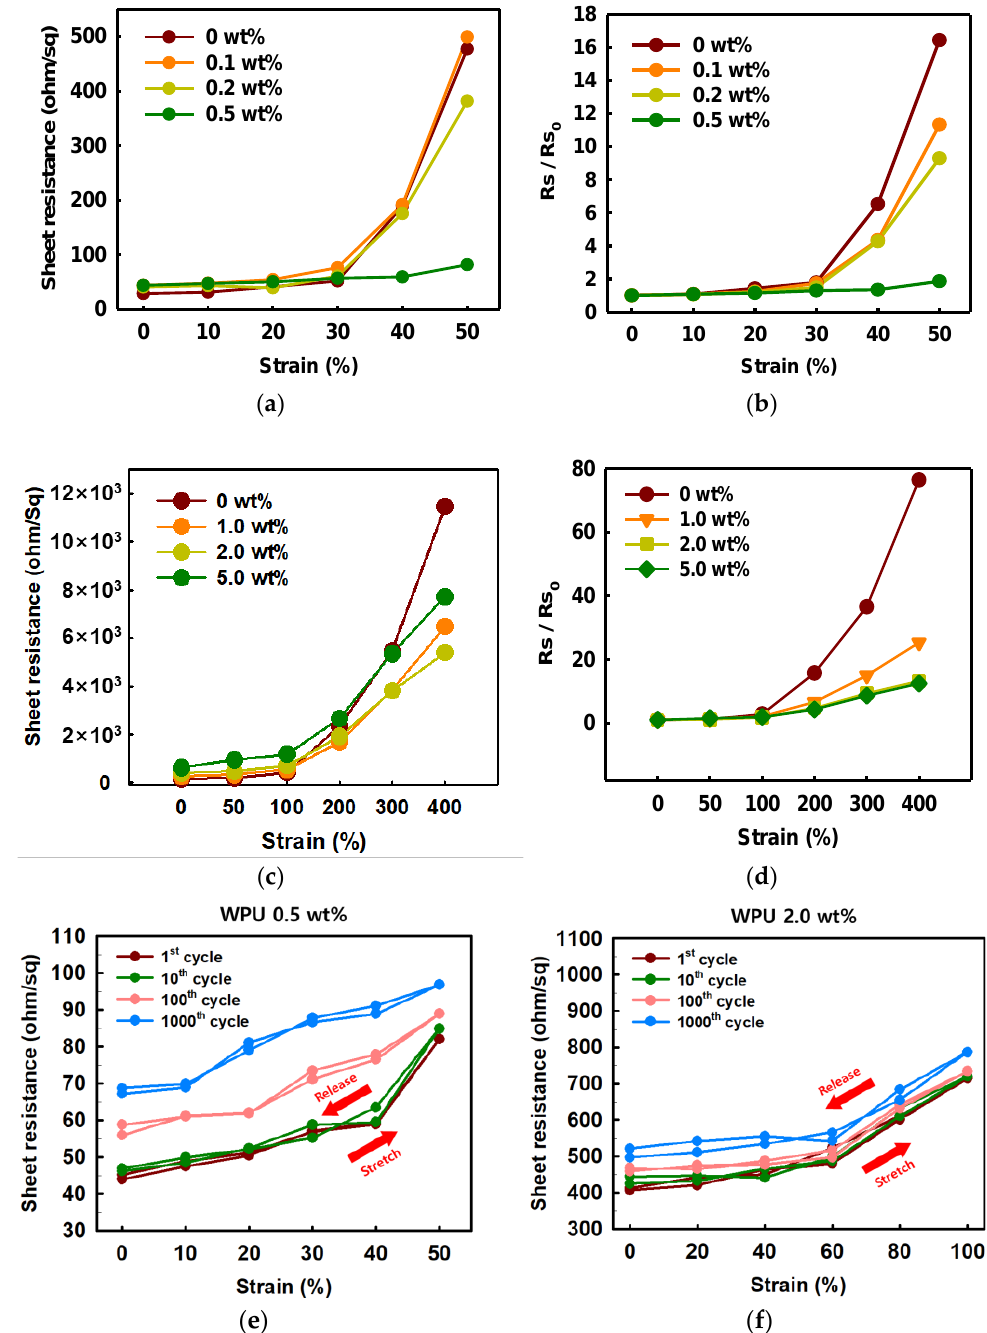
Figure 7. ( a ) Sheet resistance and ( b ) normalized sheet resistance of PEDOT:PSS films with various concentrations of WPU when TPU substrates were strained from 0% to 50%. ( c ) Sheet resistance and ( d ) normalized sheet resistance of PEDOT:PSS films with various concentrations of WPU when TPU substrates were strained from 0% to 400%. Strain–sheet resistance curves of PEDOT:PSS/nonionic WPU under stretch–release: ( e ) WPU 0.5 wt% at 50% strain and ( f ) WPU 2.0 wt% at 100% strain.